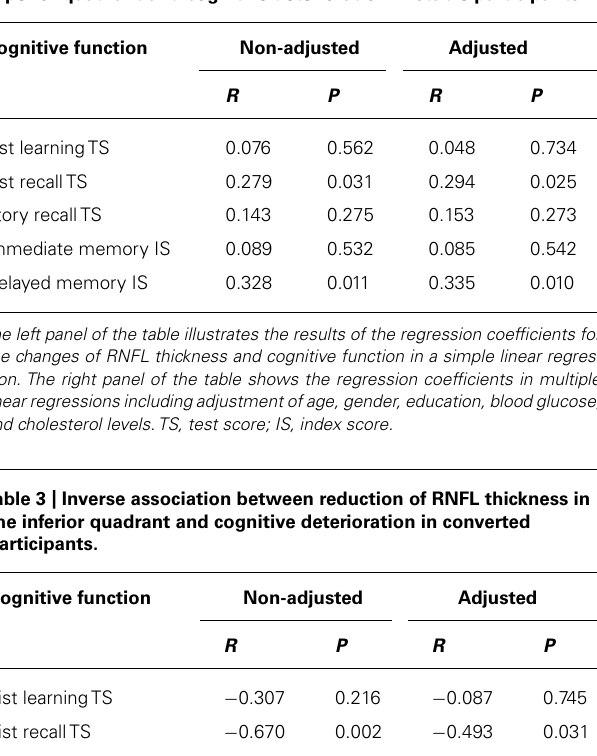
Table 1 | Demographics characteristics for participants assessed at 25 months.